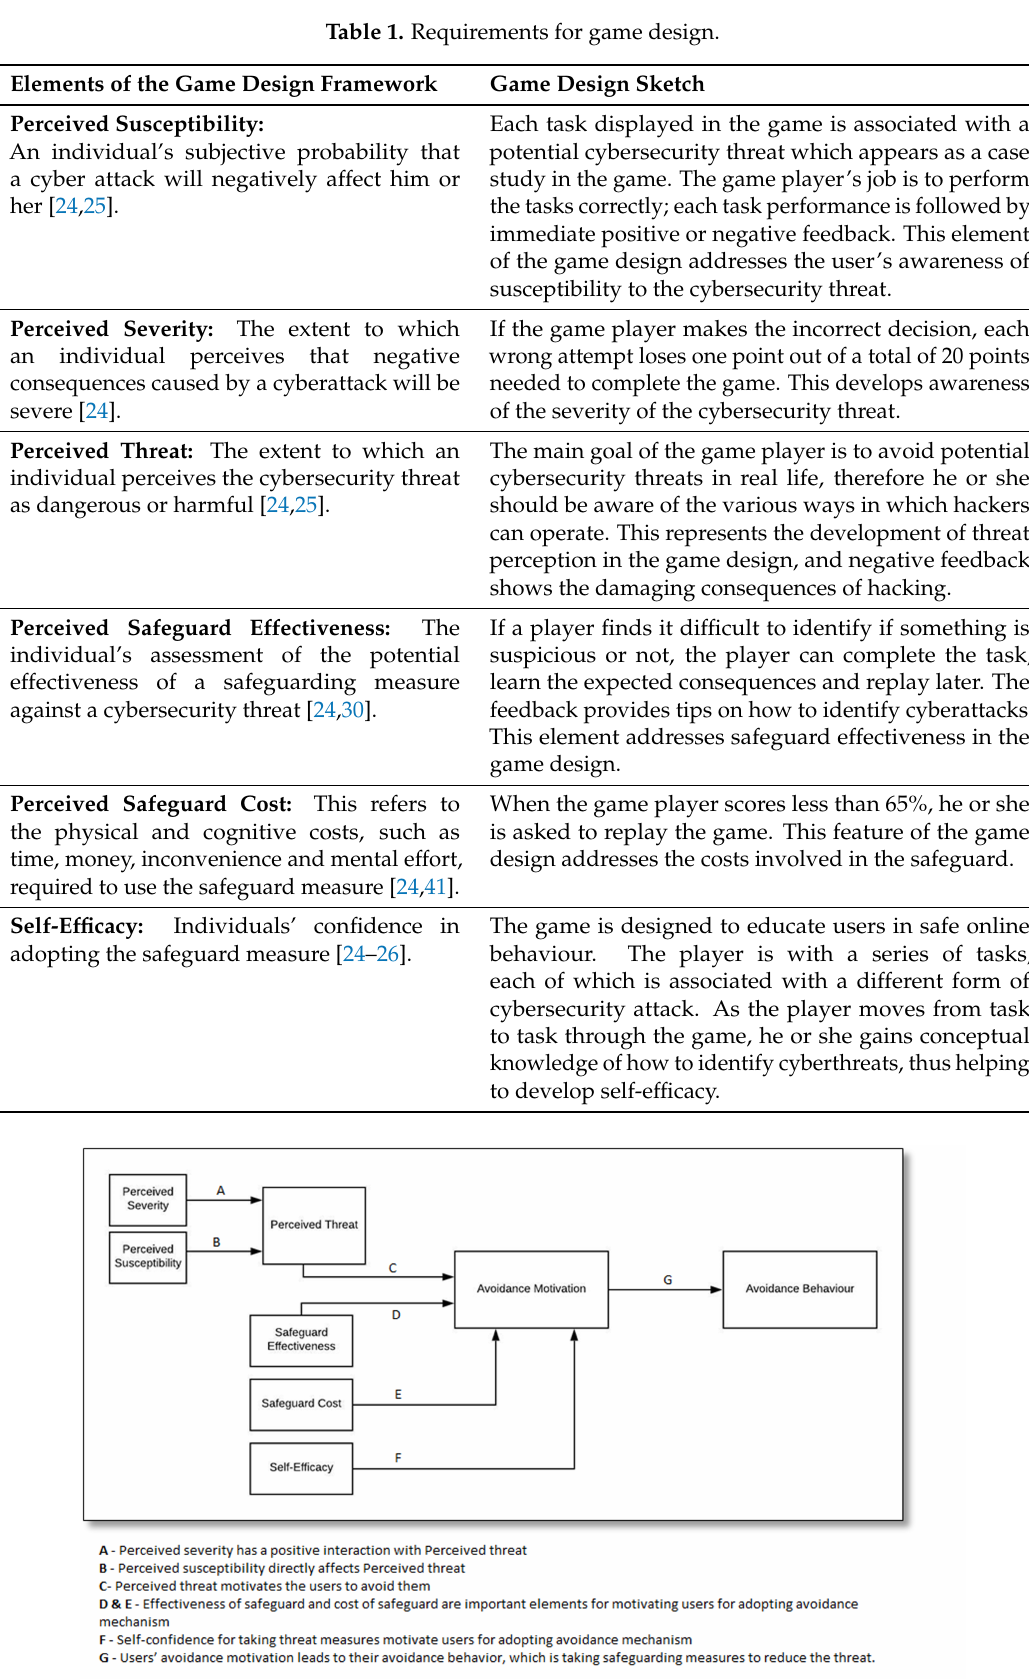
Figure 1. Game design